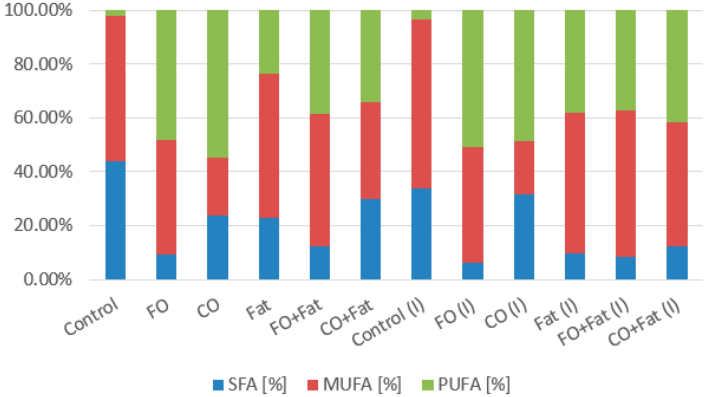
Figure 9. Phase II: Fatty acid production of Rhodotorula toruloides cultivated on waste lipid media with and without lipase induction.